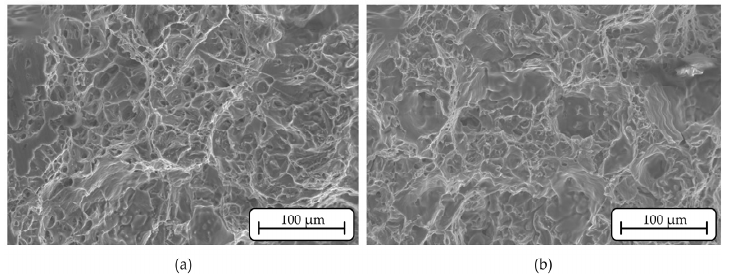
Figure 6. Fracture surfaces obtained by scanning electron microscopy (SEM) from deposited ER5356 aluminum tensile specimens cut from ( a ) wall set #1 and ( b ) wall set #2.